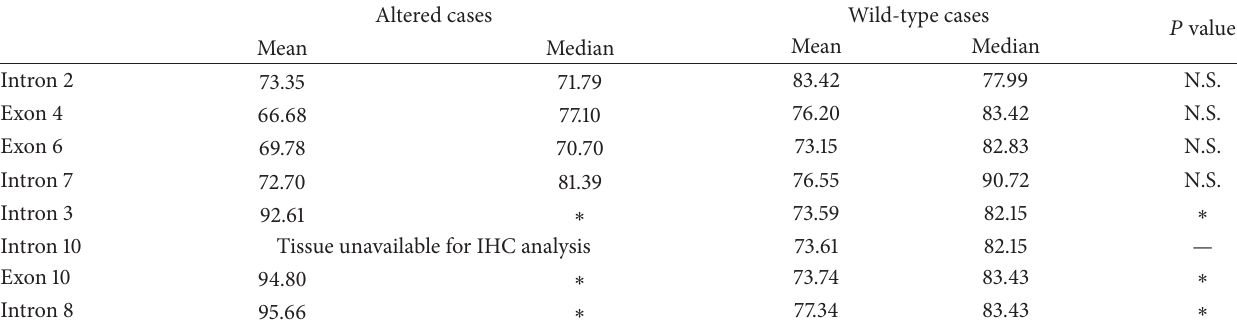
Table 4: Comparison between p53 IHC profile and corresponding TP53